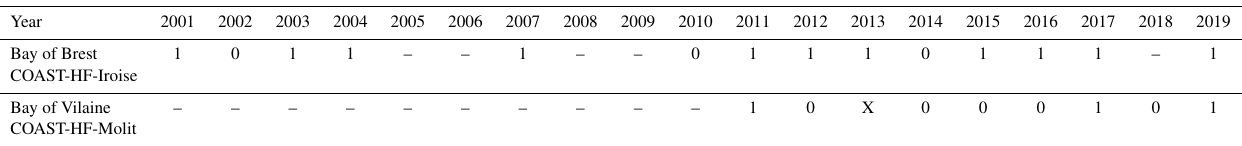
(Table 4): temperate SST (10 ◦ C), weak wind (3 m s − 1 ), a